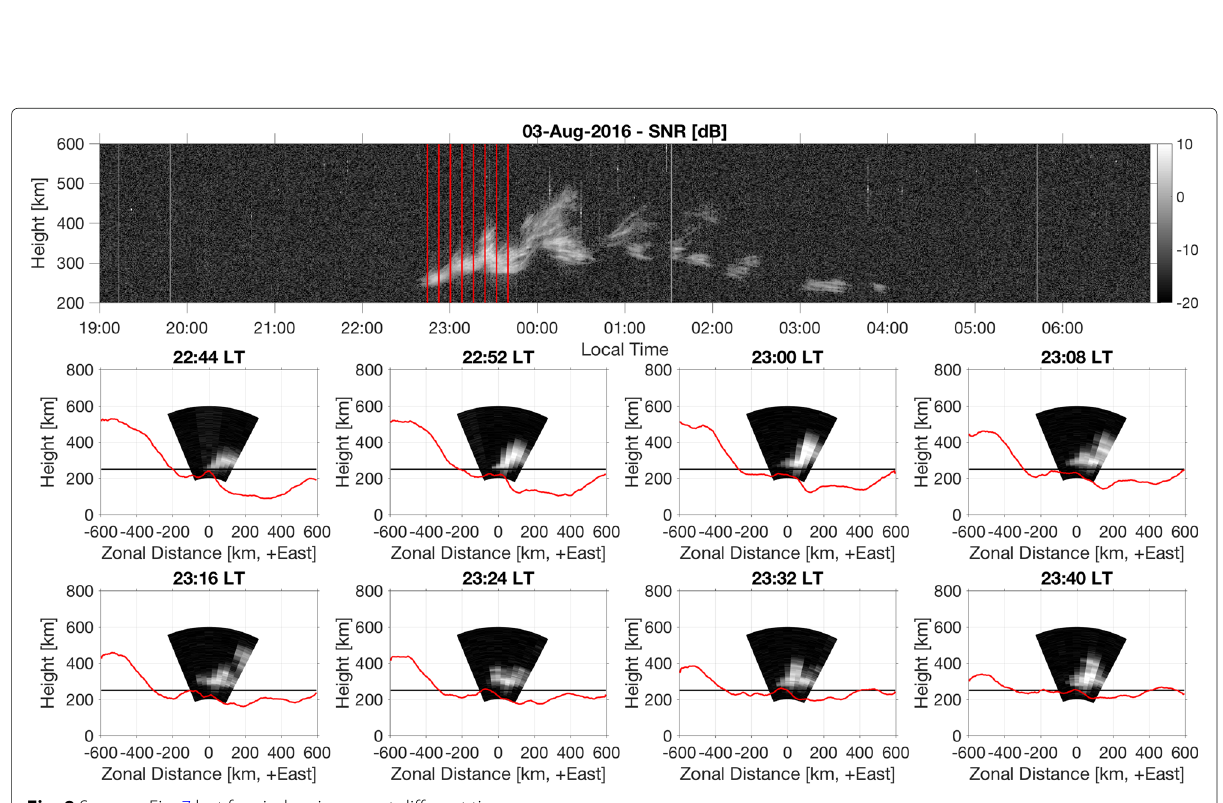
Fig. 8 Same as Fig. 7 but for airglow images at different